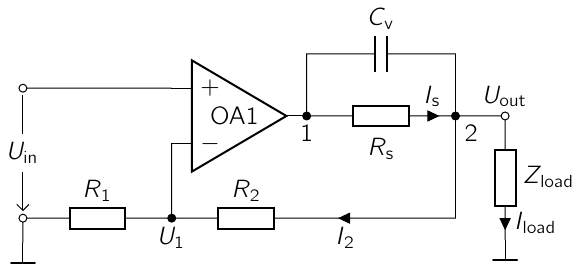
Figure 3: Circuit of a VS for BIS measurements, based on the non-inverting amplifier with additional current sense resistor R s in the feedback loop. Its purpose is to limit the maximum current through Z load . U out ( R 3 ; R = const ) out x